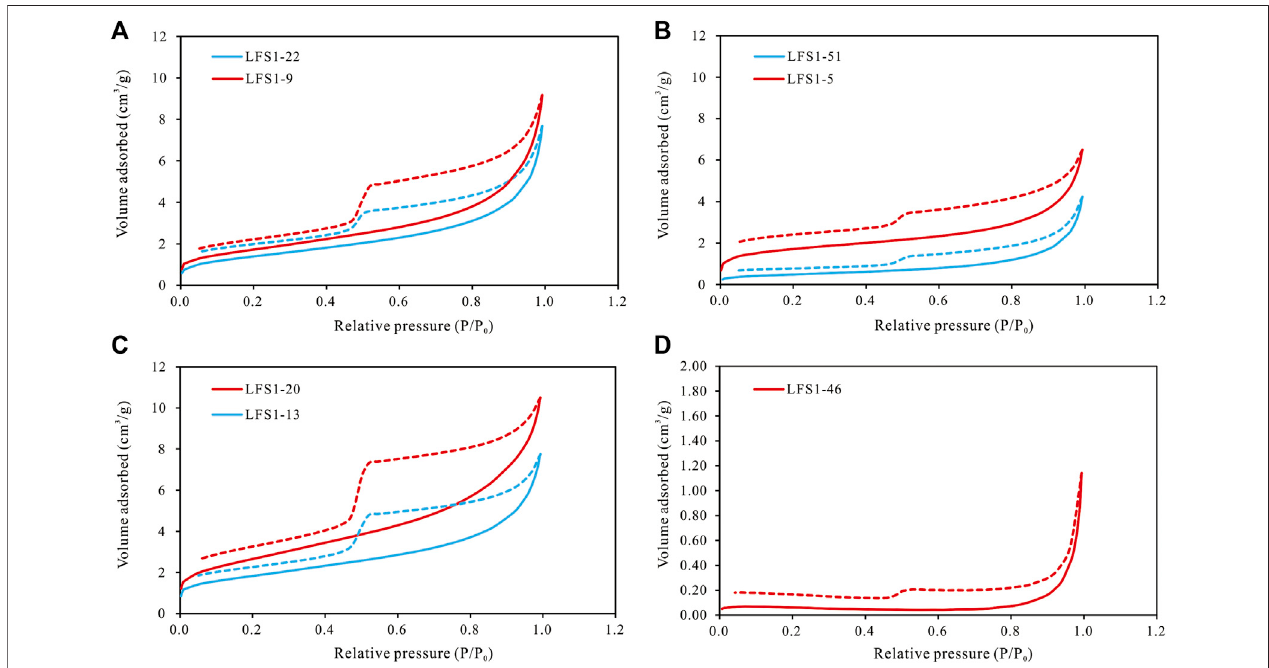
FIGURE3 | N 2 adsorptionisotherms offour types oflithofacies forshale samples inthe Shahezi Formation. (A) ORSshale; (B) ORM shale; (C) ORAshale; and (D) ORC shale.